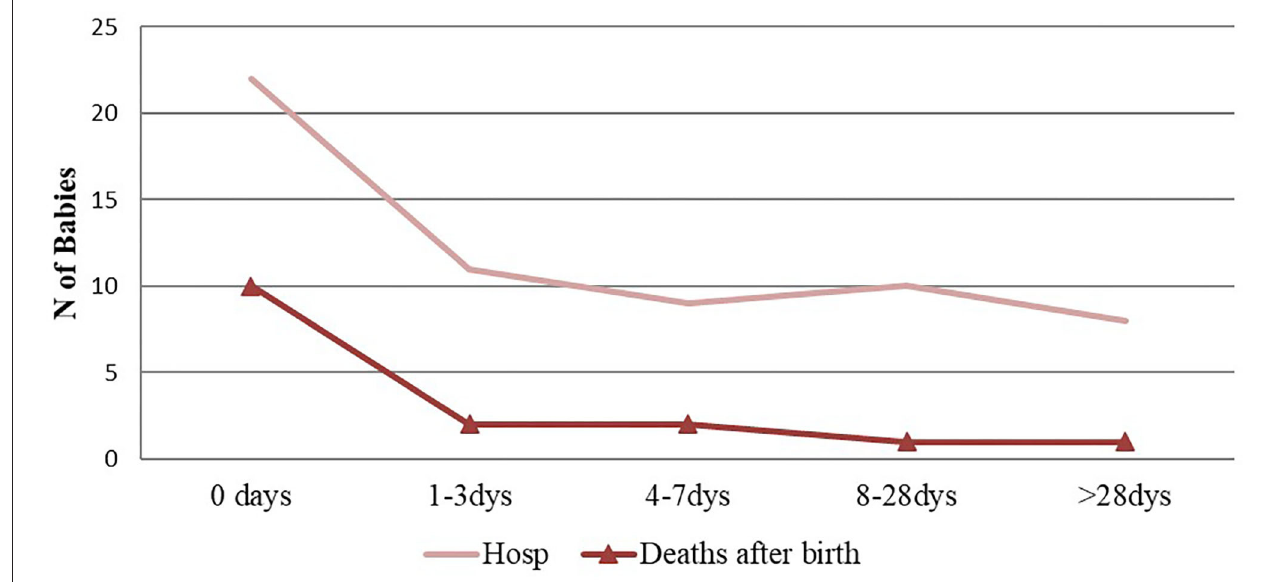
FIGURE 1 | Pattern of hospitalization and deaths during the study period (0–56) days.